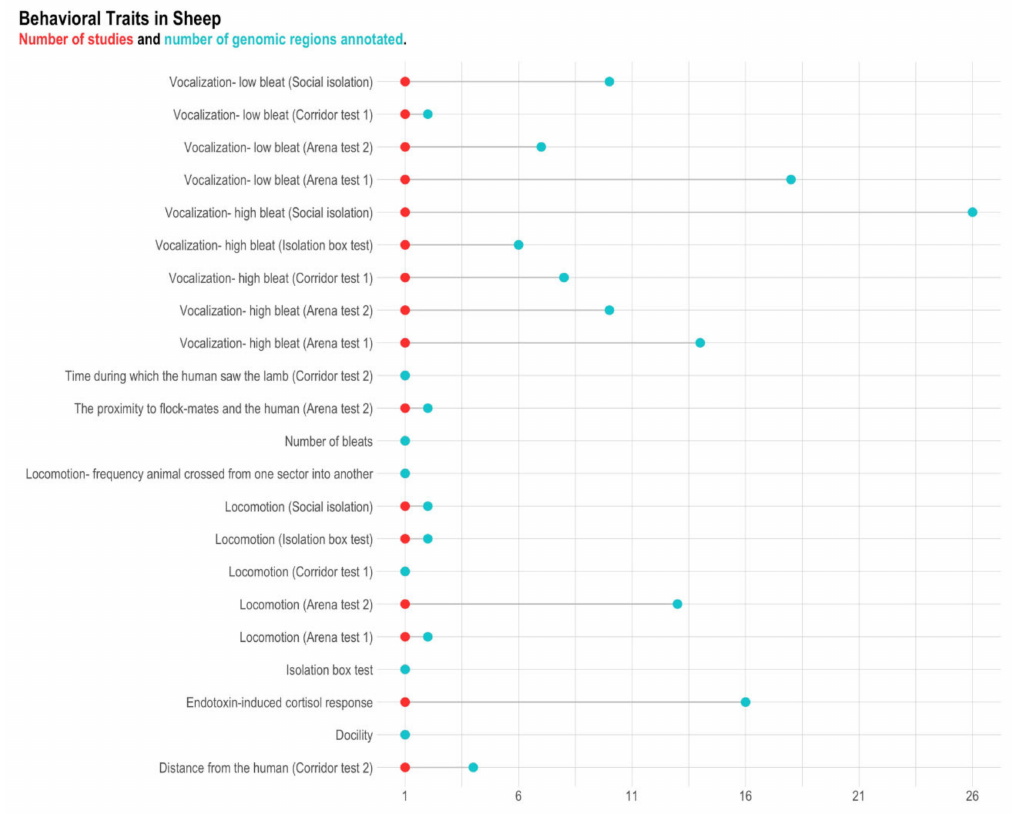
Figure 6. Number of genomic regions annotated and reference per behavior-related trait in sheep. The red dots represent the number of references, and the blue dots represent the number of genomic regions. Traits with a single-colored dot (e.g., time during which the human saw the lamb) mean that the number of references is equal to the number of genomic